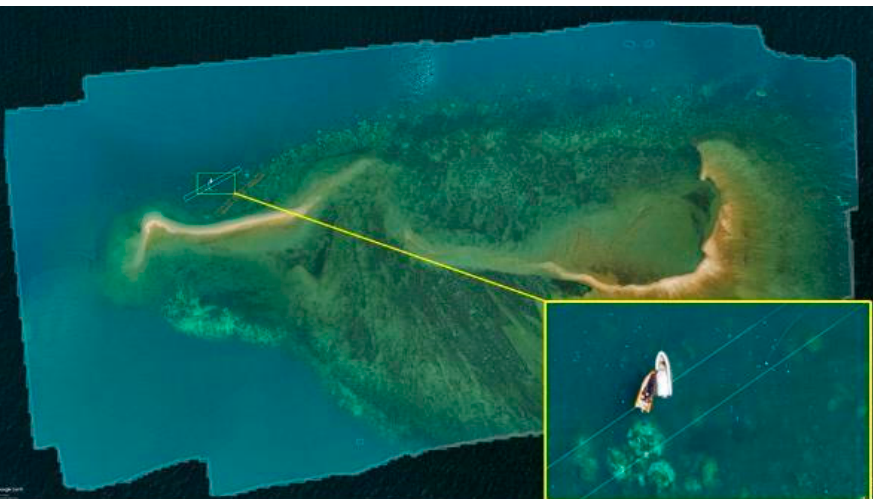
Figure 14. Photogrammetry orthomosaic of Pandora Reef (63 Ha) shows areas of day long in-water surveys performed by AIMS at the depth of 3 m (orange area) and 6 m (white area) 400% zoomed fragment on the bottom right (tide height 2.6